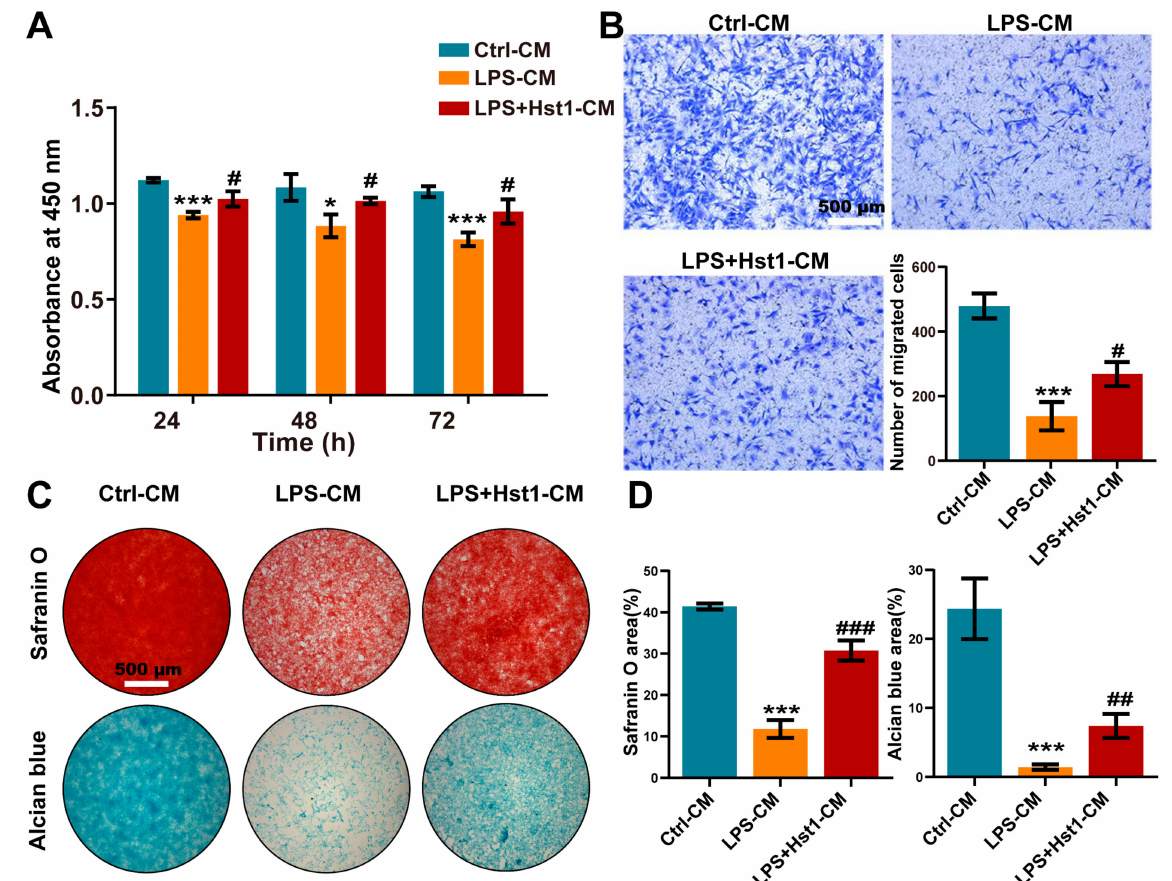
Figure 8. CM from Hst1-treated macrophages promoted ATDC5 cells’ metabolic activity, migration, and differentiation. ( A ) CCK8 assay was used to detect the effect of macrophage CM on the metabolic activity of ATDC5 cells. ( B ) Transwell was used to observe ATDC5 cells migration, scale bar = 500 µ m. ( C , D ) Safranin O and Alcian blue staining of ATDC5 cells cultured with macrophage CM for 7 days and quantification, scale bar = 500 µ m. Data are expressed as mean ± SD from three independent experiments. Significant differences compared to the control-CM group: * p < 0.05 and *** p < 0.001, and compared to the LPS-CM group: # p < 0.05, ## p < 0.01, and ### p <